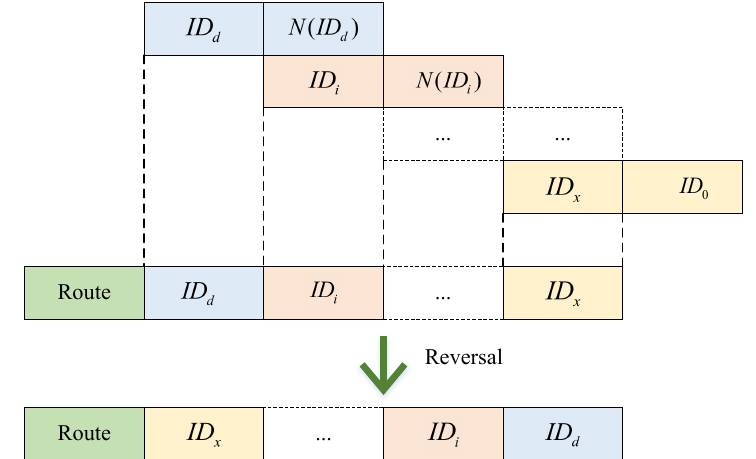
Figure 4. Route-building process.